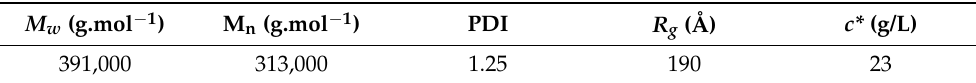
Table 1. PMAA characteristics. Molar masses and PDI are determined by SEC, R g by SAXS and c* by using Equation